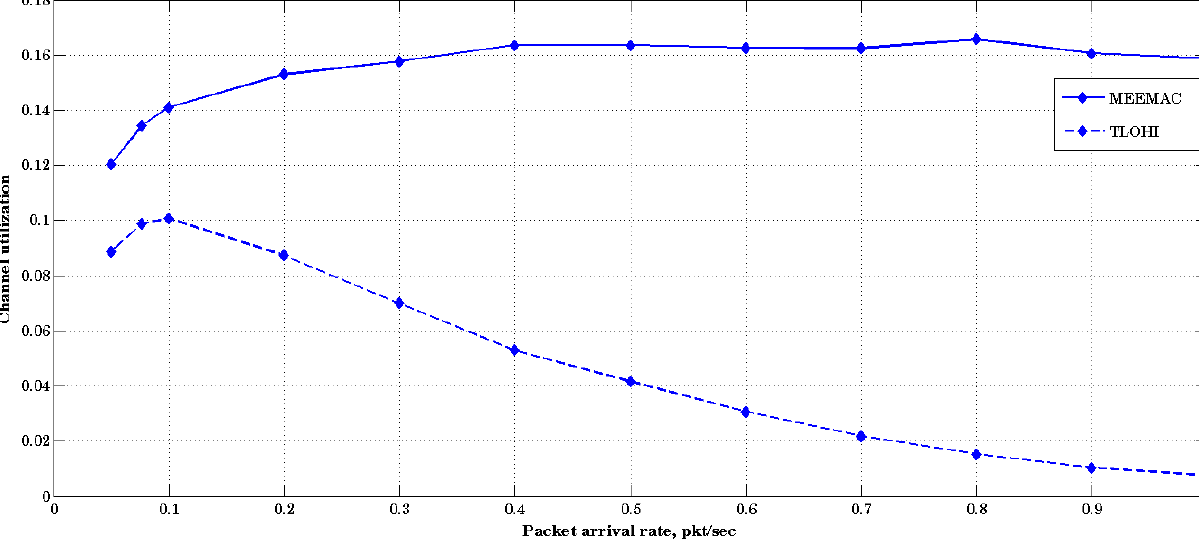
Figure 19. Channel utilization for T-Lohi and